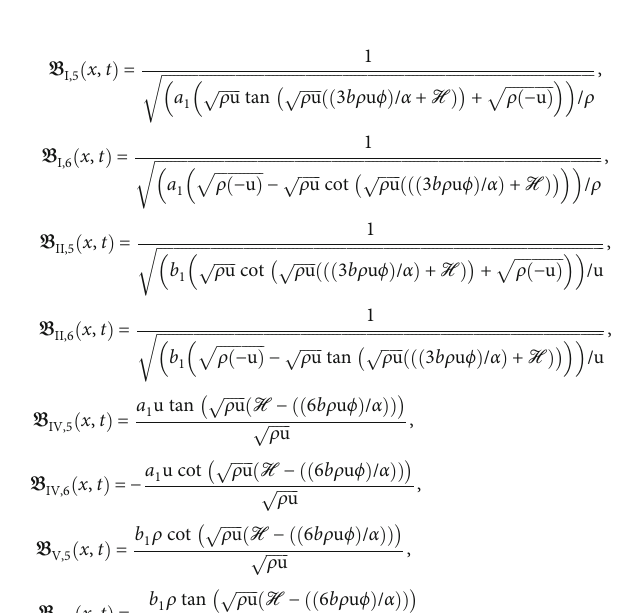
r p(cid:5) (cid:6)(cid:5) (cid:6)